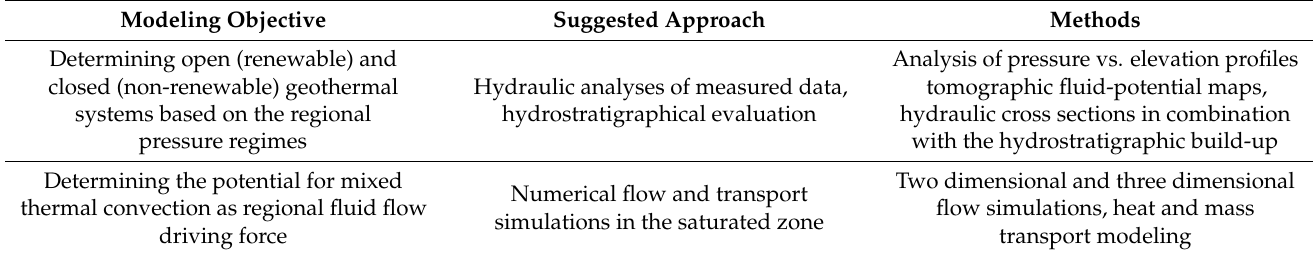
Table 7. Deep geothermal energy evaluation.